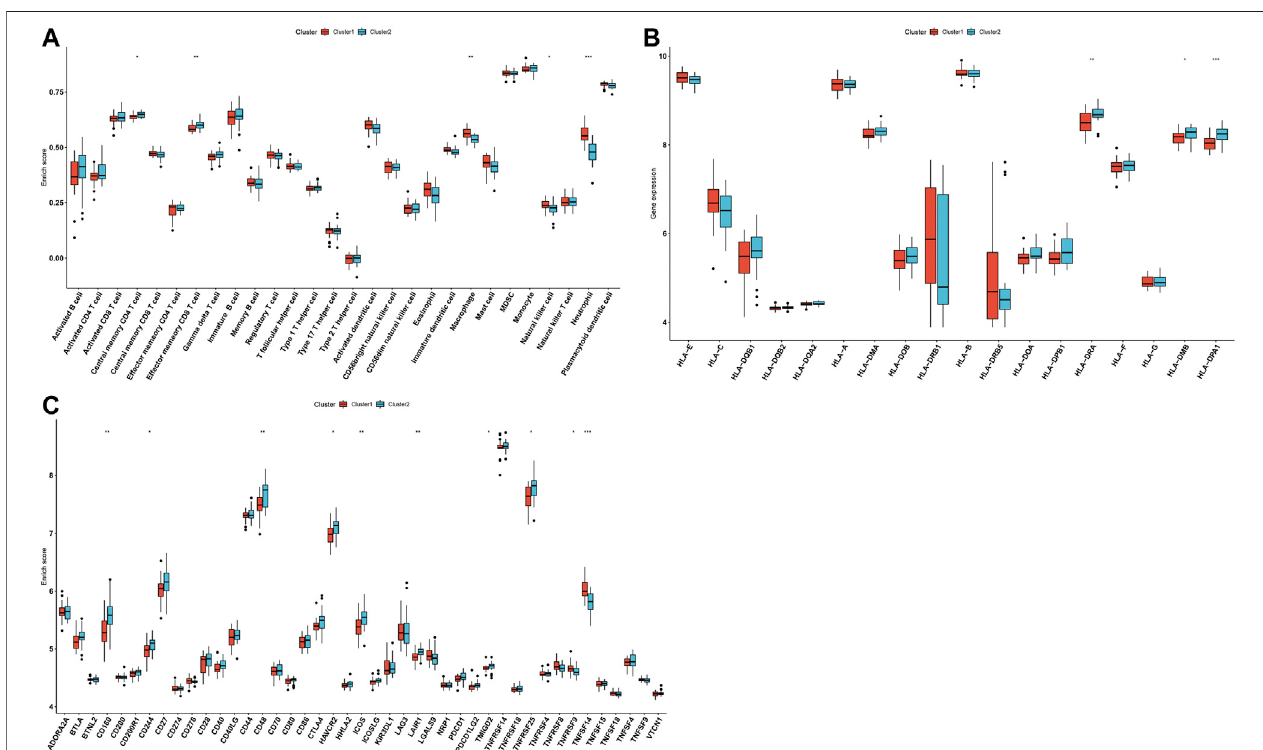
FIGURE5| Aging-relatedgeneclusterswithdifferentimmuneactivations. (A) Boxplotsofthedifferencesinimmunecellin fi ltrationsinaging-relatedgeneclusters1 and2. (B) BoxplotsofthedifferencesinmRNAexpressionofHLAmoleculesinaging-relatedgeneclusters1and2. (C) BoxplotsofthedifferencesinmRNAexpression of immune checkpoints in aging-related gene clusters 1 and 2. * p < 0.05; ** p < 0.01; *** p <